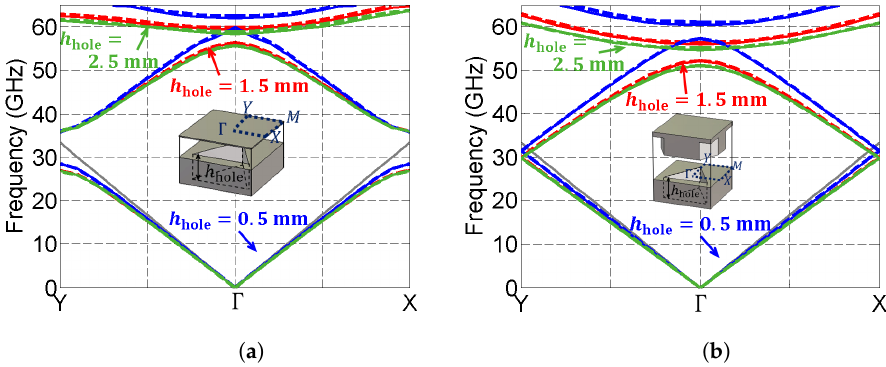
Figure 6. Dispersion diagram of the ( a ) mirror-symmetric and ( b ) glide-symmetric unit cells when varying the hole depth. Dashed lines represent the results extracted from CST and solid lines the results extracted from the mode-matching. The light line is displayed in gray. The geometrical parameters of the unit cells are: g = 0.5mm, h t = 3mm, and d x = d y = 4.5mm.